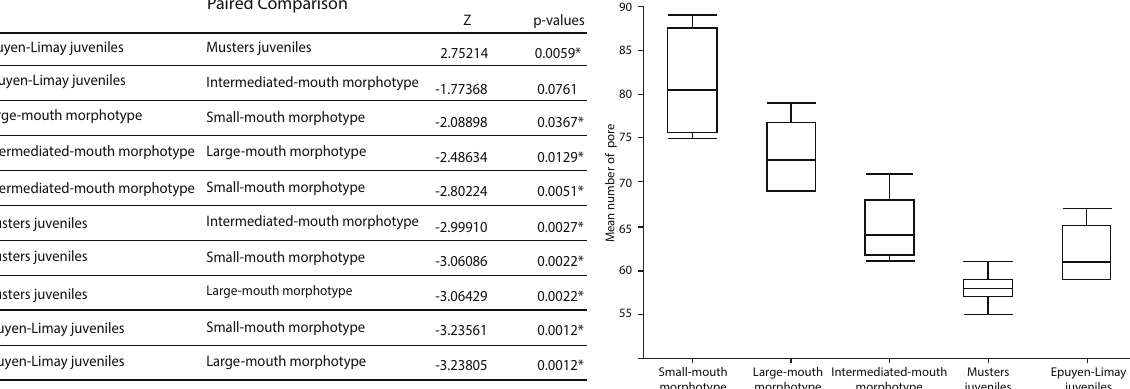
Figure 12. Paired comparison and box plot showing the mean values for the total number of pores among the small-mouth morphotype, the large-mouth morphotype, the intermediated-mouth morphotype, and the Musters and Epuyen-Limay groups of juveniles. *Shows significant differences. Significance level: